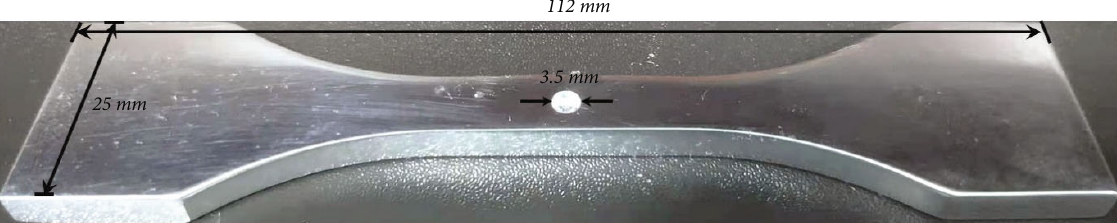
Figure 1: A specimen with a drilled hole.